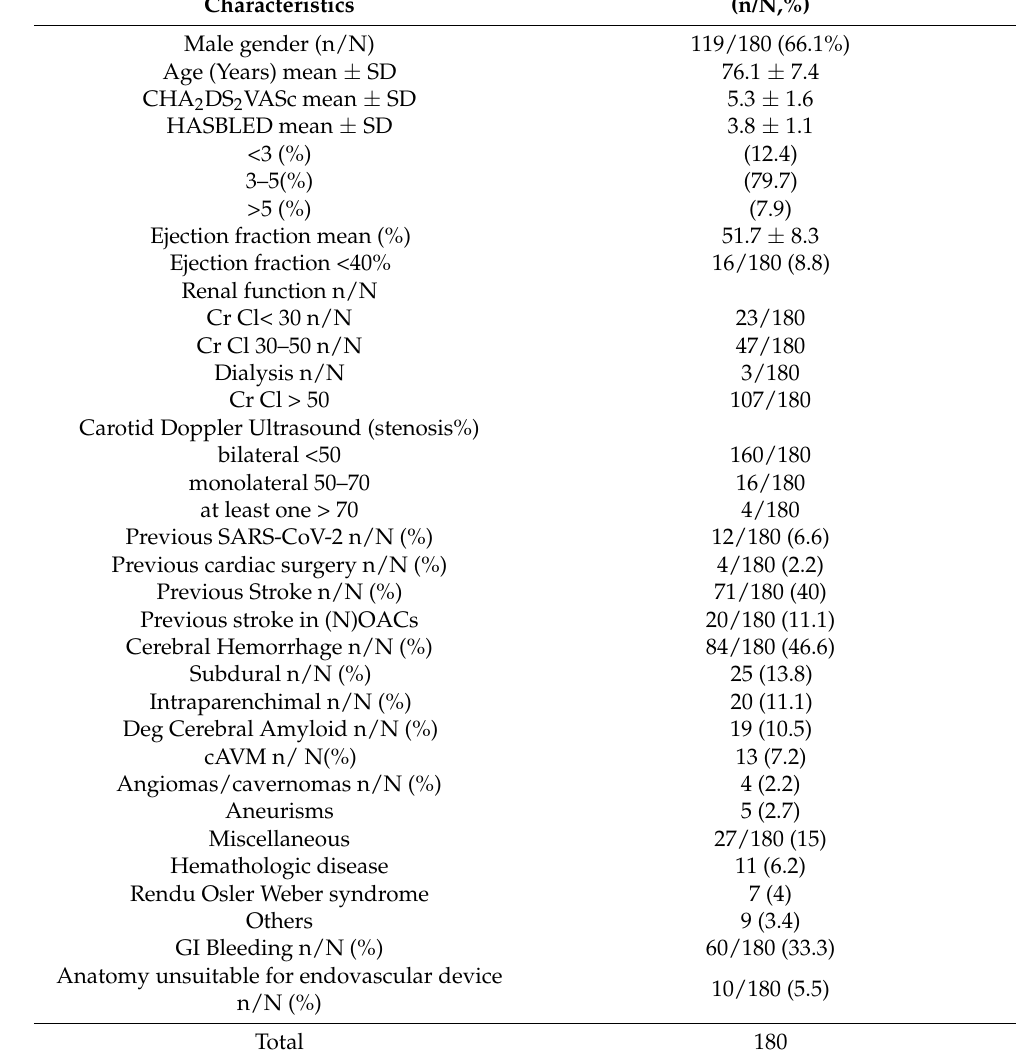
Table 1. Patients